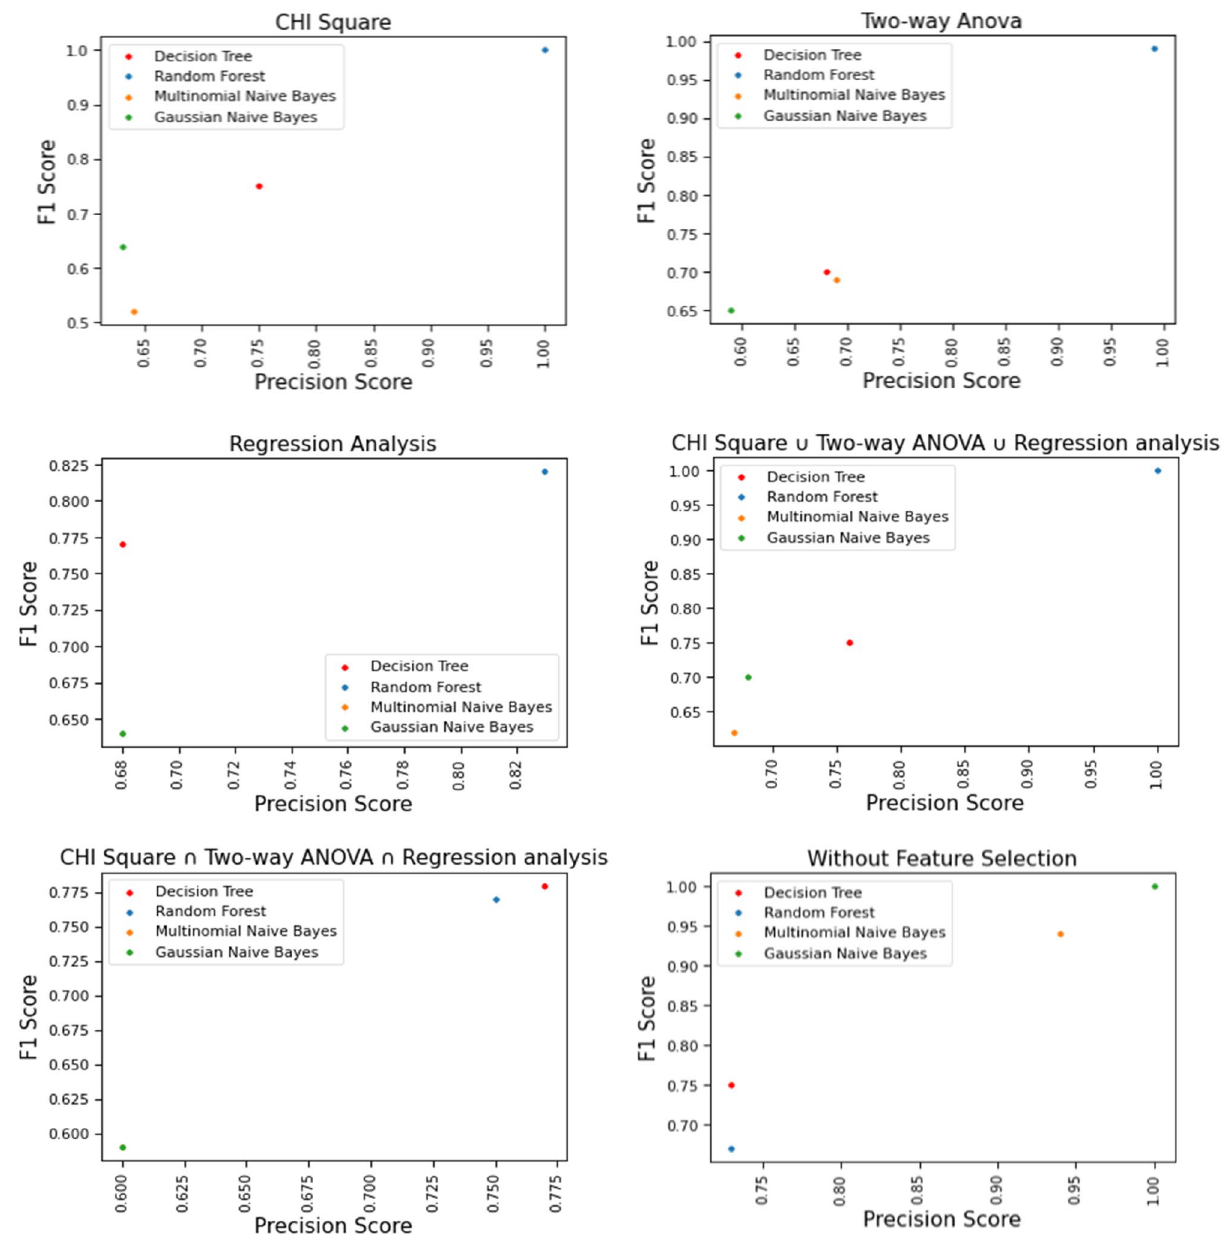
Figure 9. Performance of several machine learning algorithms and feature selection